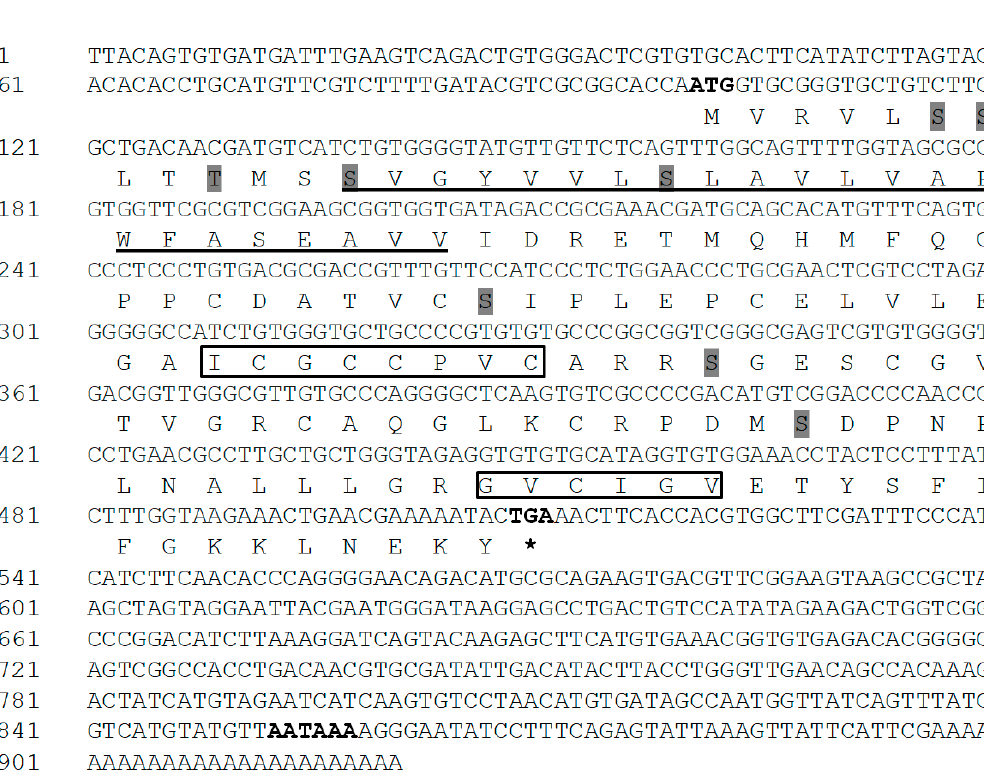
Figure 1. Full-length cDNA and deduced amino acid sequences of Hdh IGFBP-5. Initiation and termination codons (asterisks), putative polyadenylation signals are shown by bold font. The transmembrane region is underlined. Potential phosphorylation sites are marked with shadow. Characteristic motifs (XCGCCXXC and GVCXXV) are denoted by black boxes.